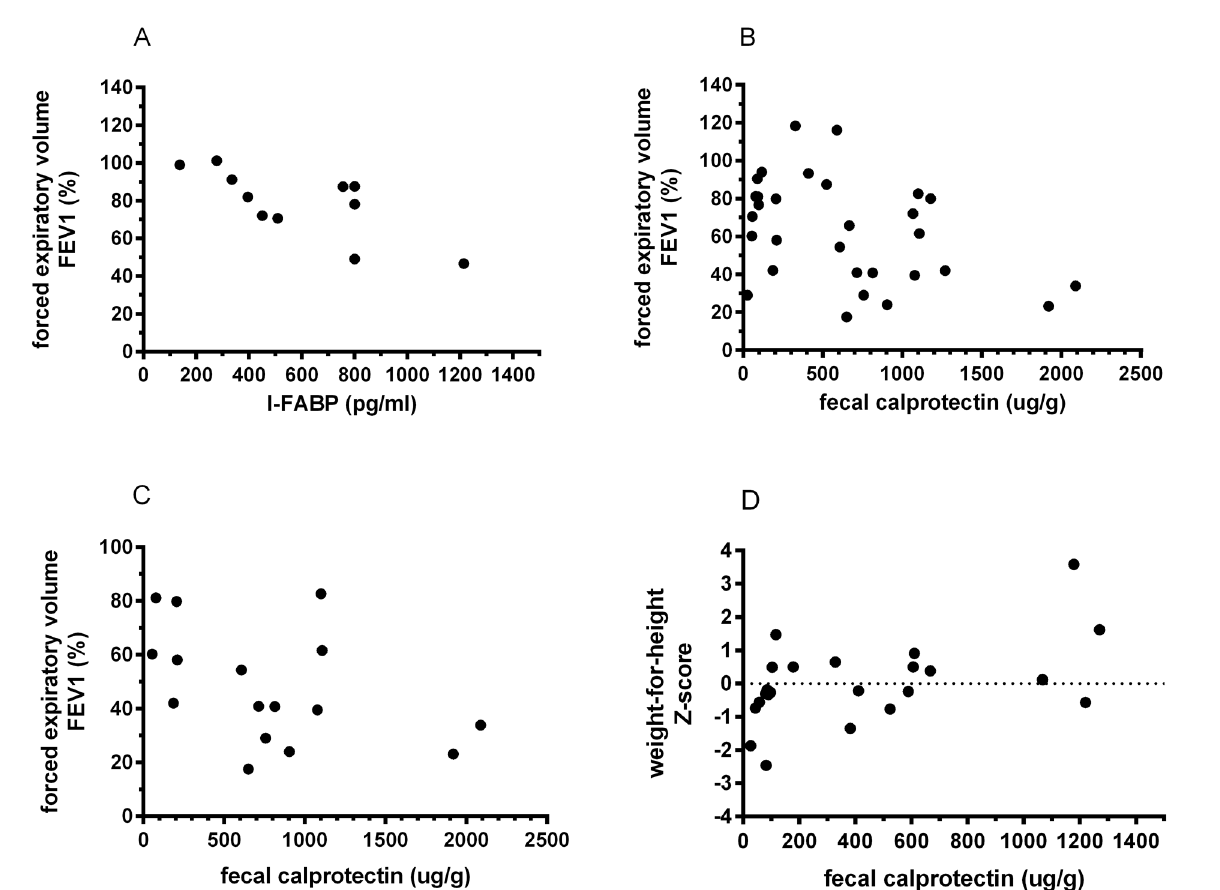
Fig 2. Serum I-FABP level correlated inversely with forced expiratory volume (FEV1) in children with cystic fibrosis (CF) (A). Faecal calprotectin level correlated inversely with FEV1 in the total CF group (B) and in CF adults (C). Faecal calprotectin level was significantly correlated with weight-for-height Z- score in CF children